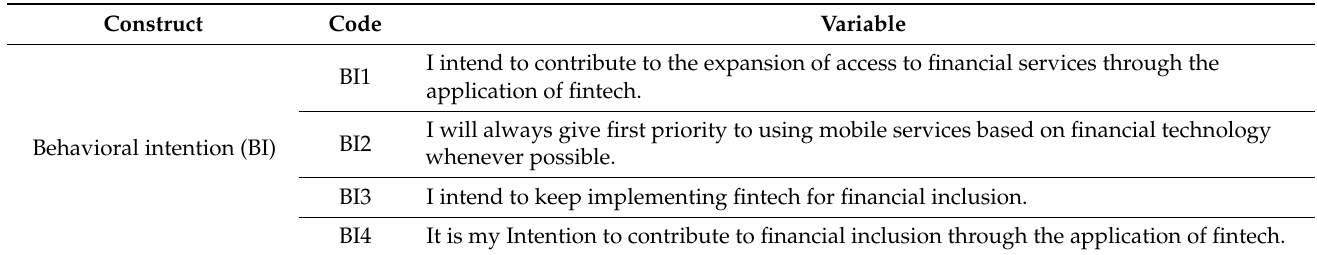
Table 1. Constructs and